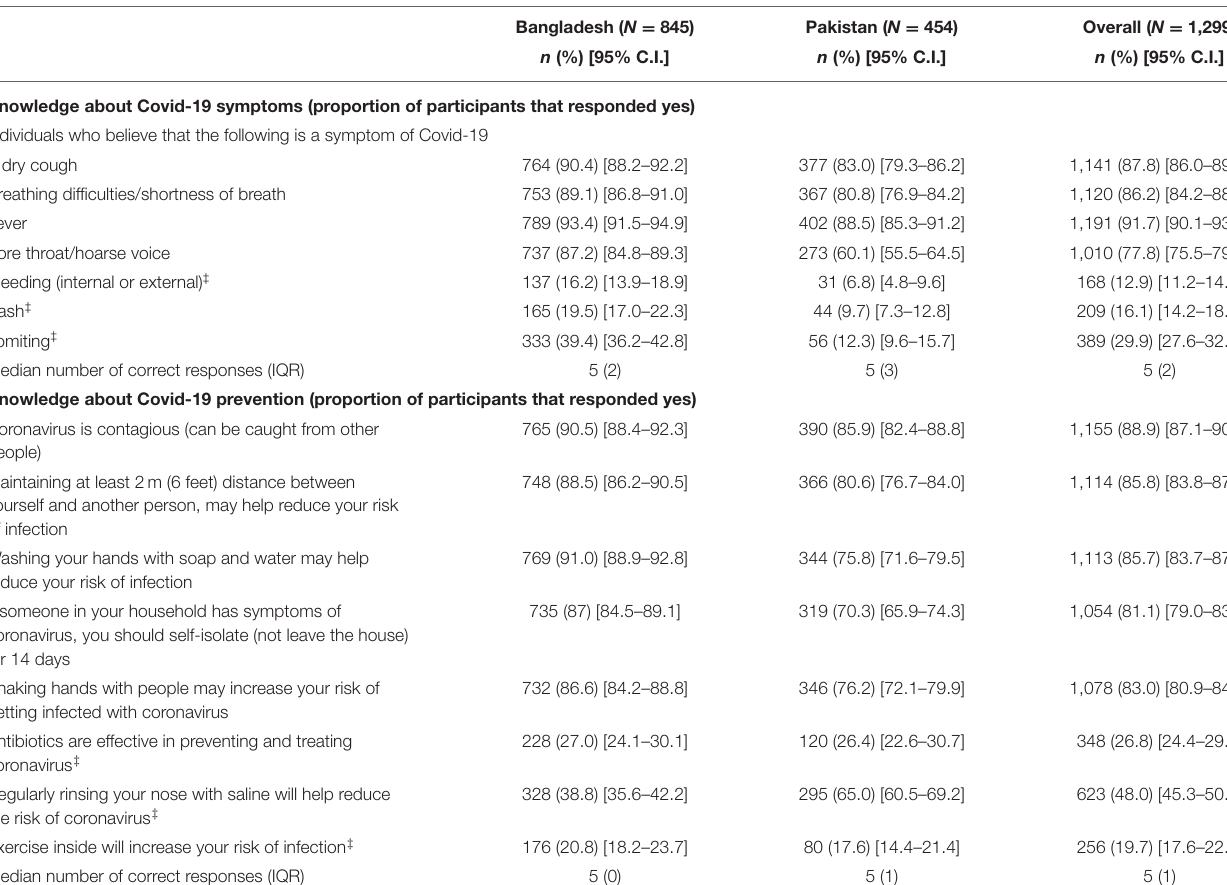
TABLE 3 | Knowledge relevant to the COVID-19 epidemic.